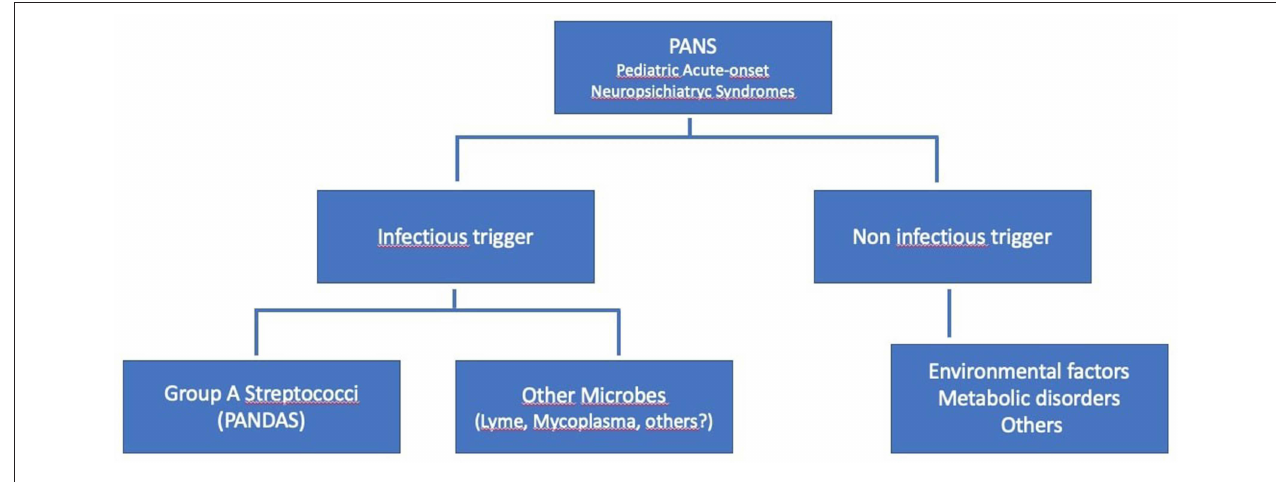
FIGURE 1 | Hierarchy of the Pediatric PANS, modified from Swedo et al.